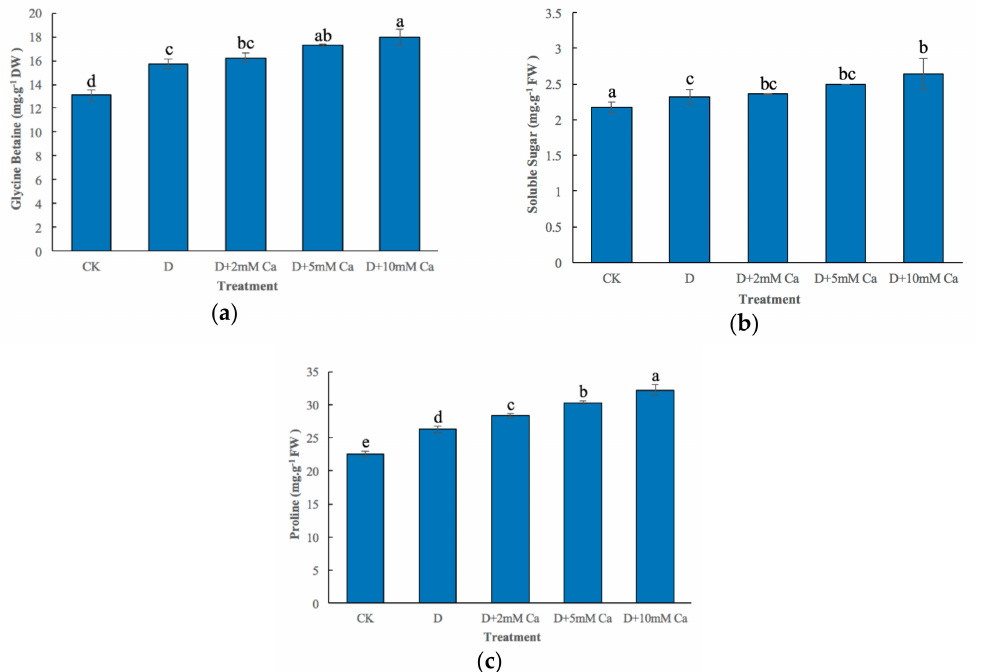
Figure 3. E ff ects of exogenous calcium on the content of proline ( a ), soluble sugar ( b ) and glycine. Betaine ( c ) in H . bodinieri under drought